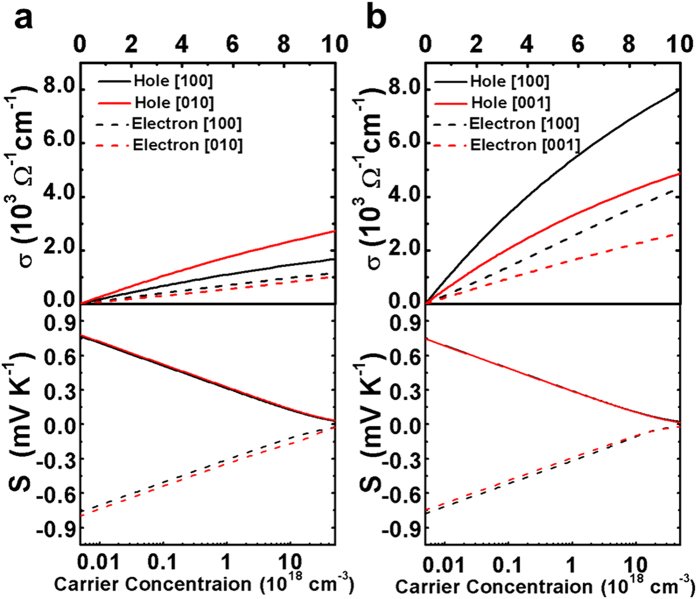
Electrical conductivity and thermopower as a function of carrier concentration at 300 K.(a) Cubic CH3NH3PbI3. (b) Tetragonal CH3NH3PbI3.